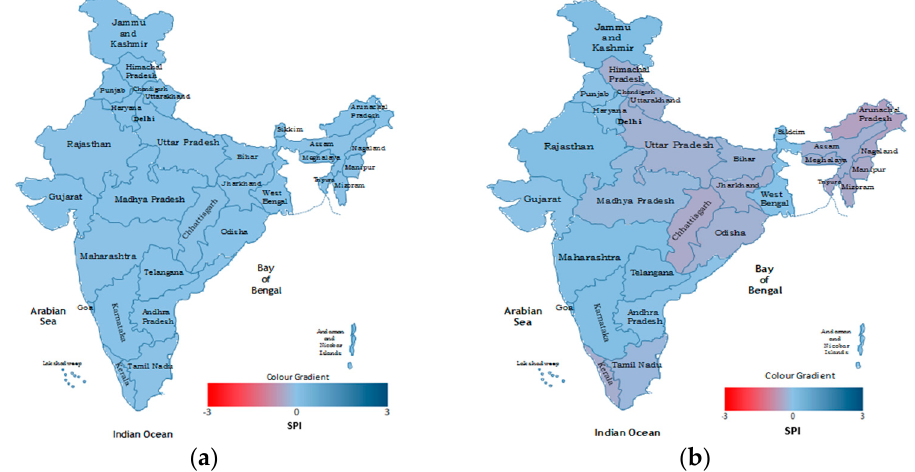
Figure 6. Average drought levels in India ( a ) 117 years. ( b ) Recent 50 years (Source for template: https://indzara.com/wp-content/uploads/2013/04/indzara_Geographic_Heat_Map_India_v4.xlsx (accessed on 4 December 2022).